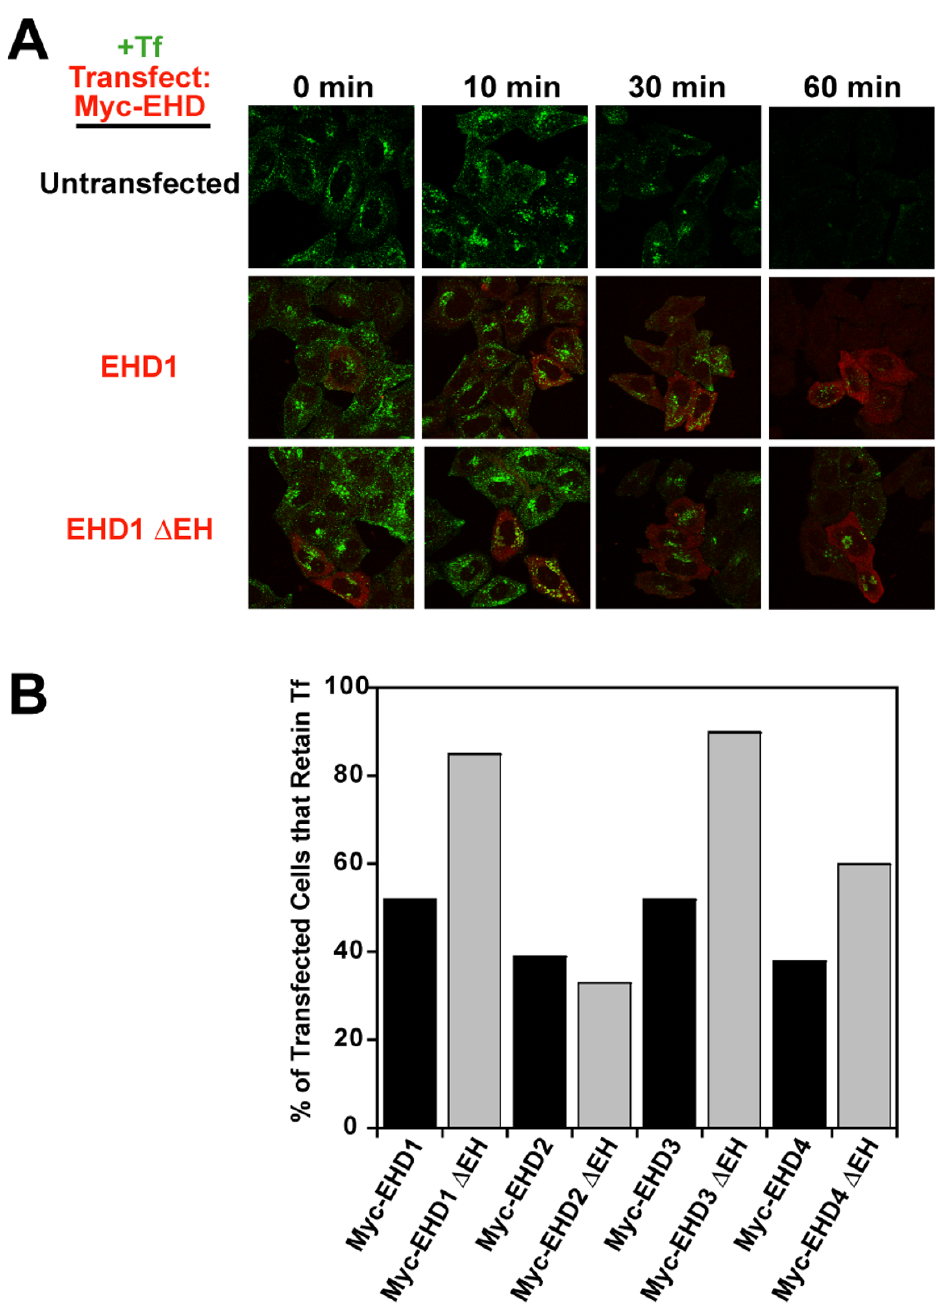
Figure 9 Differential effects of wild type and ∆ EH mutants of EHD1, 3, & 4 versus EHD2 on transferrin exit from the ERC . Untransfected HeLa cells or cells transiently transfected with Myc-EHD1 or Myc-EHD1 ∆ EH were loaded with Transfer- rin-coupled Alexa Fluor 488 (Tf, green) in internalization buffer at 37°C for 30 minutes 24 h after transfection, washed with ice-cold PBS and chased with serum-containing medium. The cells were fixed at various time points, stained with antibodies for Myc (9E10, red) and scanned on a confocal microscope. Similar experiments with EHD2-4 and EHD2-4 ∆ EH are shown in Additional File 5. (B) Cells expressing Myc-EHD proteins (black bars) or Myc-EHD ∆ EH proteins (grey bars) from a represent- ative experiment were counted with respect to Tf retention after 60 min of chase. At least 200 cells were counted in each